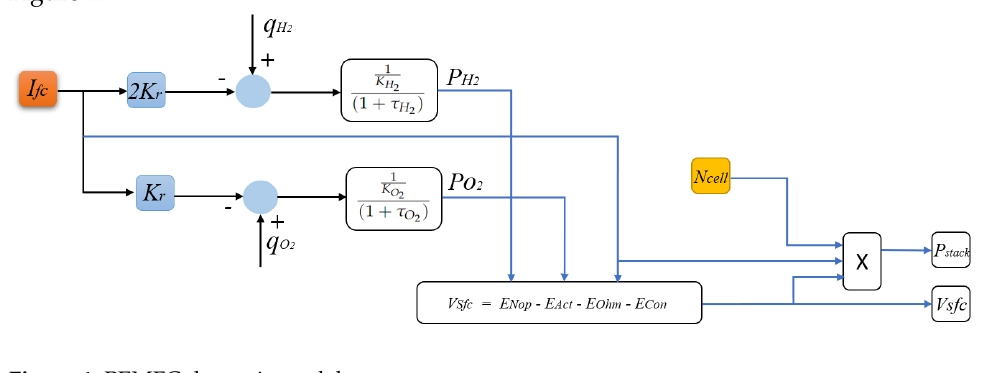
Figure 4. PEMFC dynamic